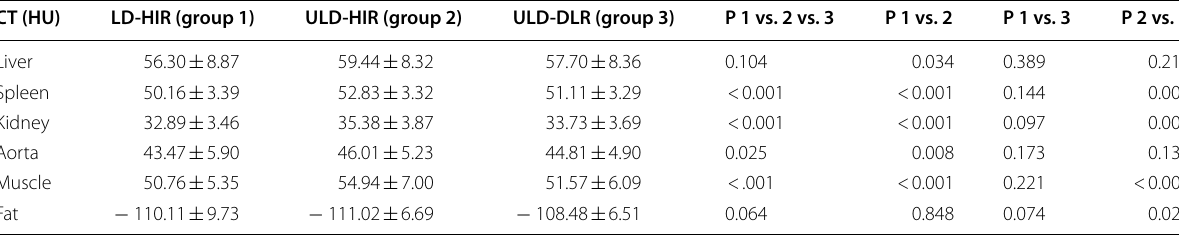
Table 1 CT values for various abdominal organs and